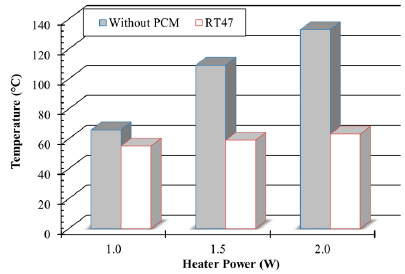
Figure 3. Comparison between PCM and no PCM heat sink temperatures for three different power ratings.